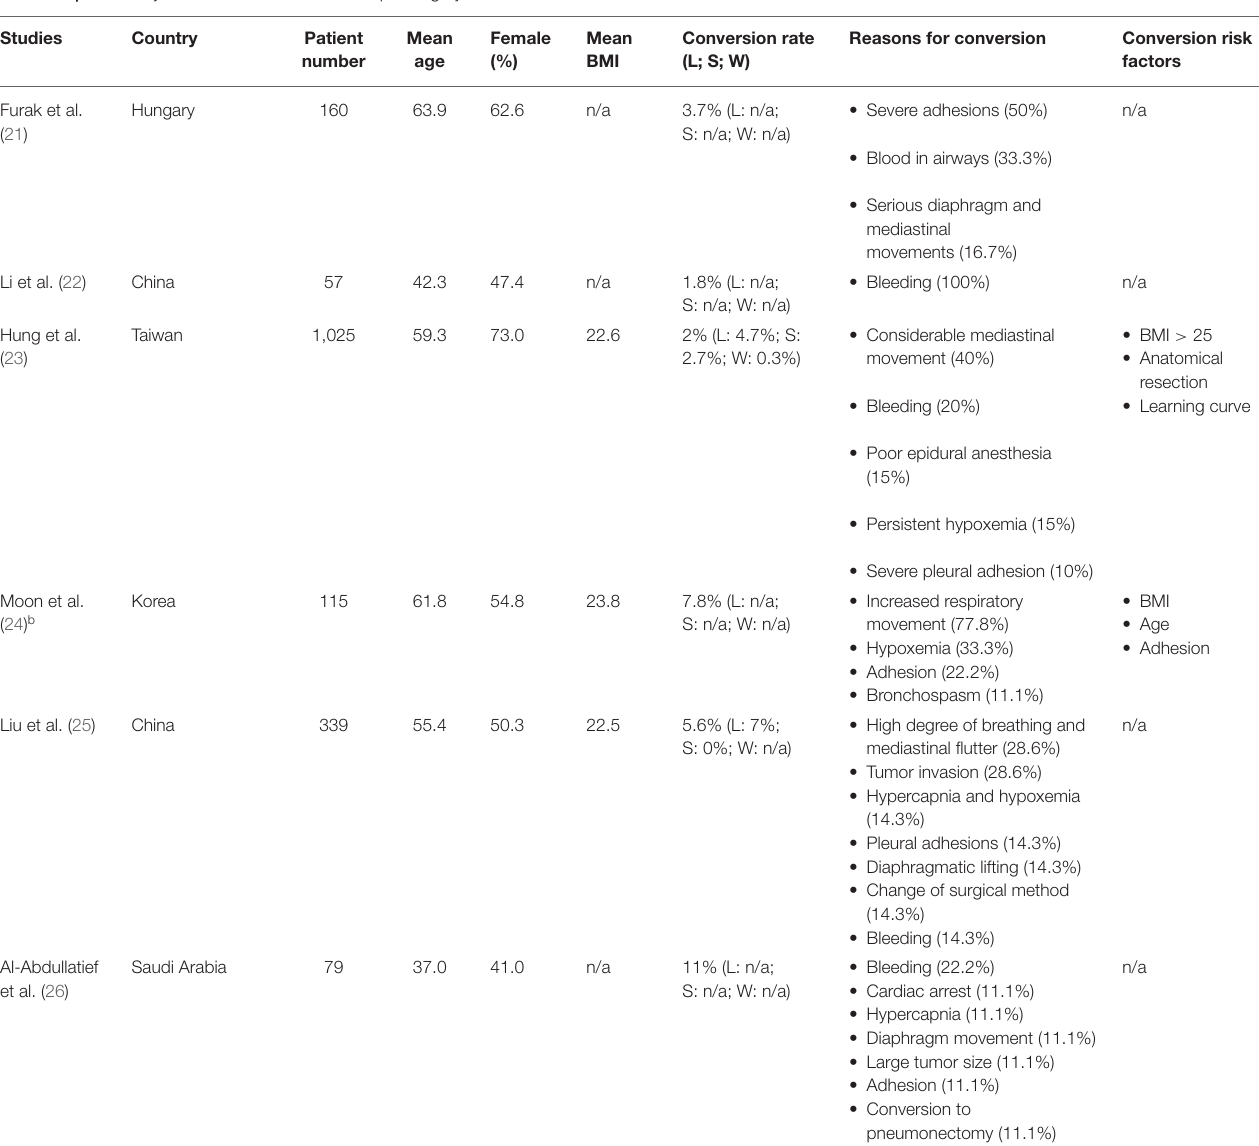
TABLE 1 | Summary of non-intubated thoracoscopic surgery studies a .